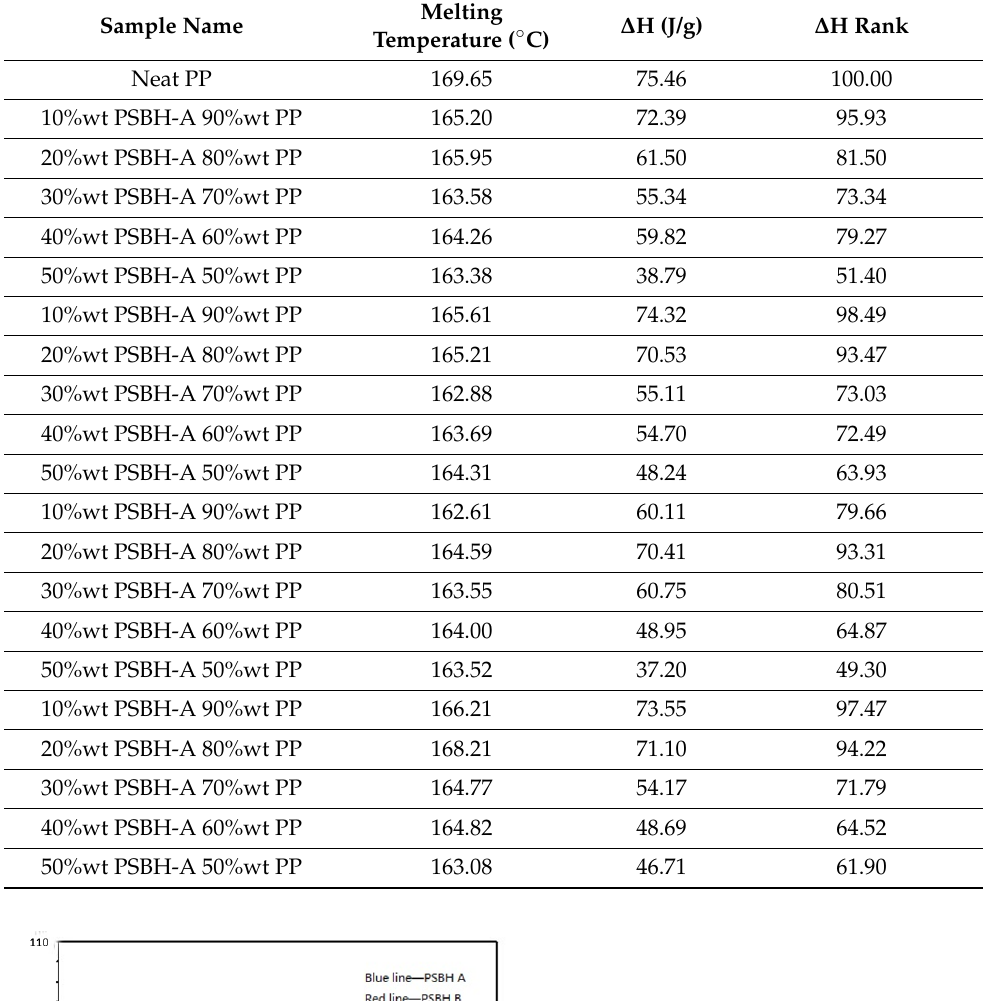
Table 3. Melting temperature and heat of fusion for PP/PSBH composites.